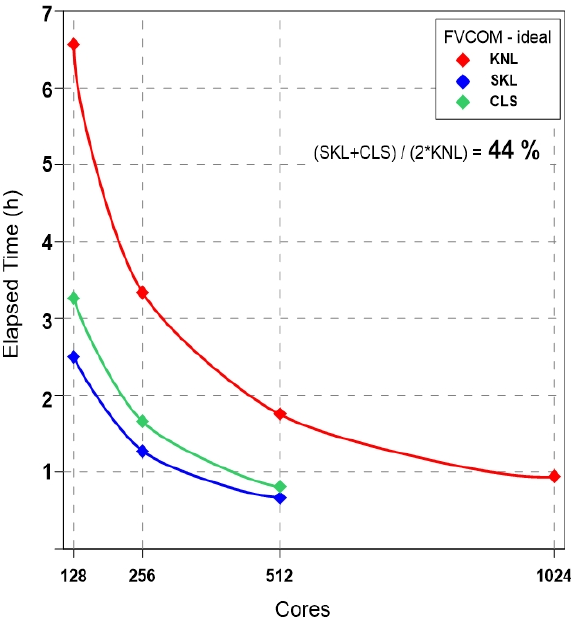
Figure 16. Performances of FVCOM-Benchmark by the number of cores for the ideal experiment: (SKL + CLS) / (2*KNL) = 44%.